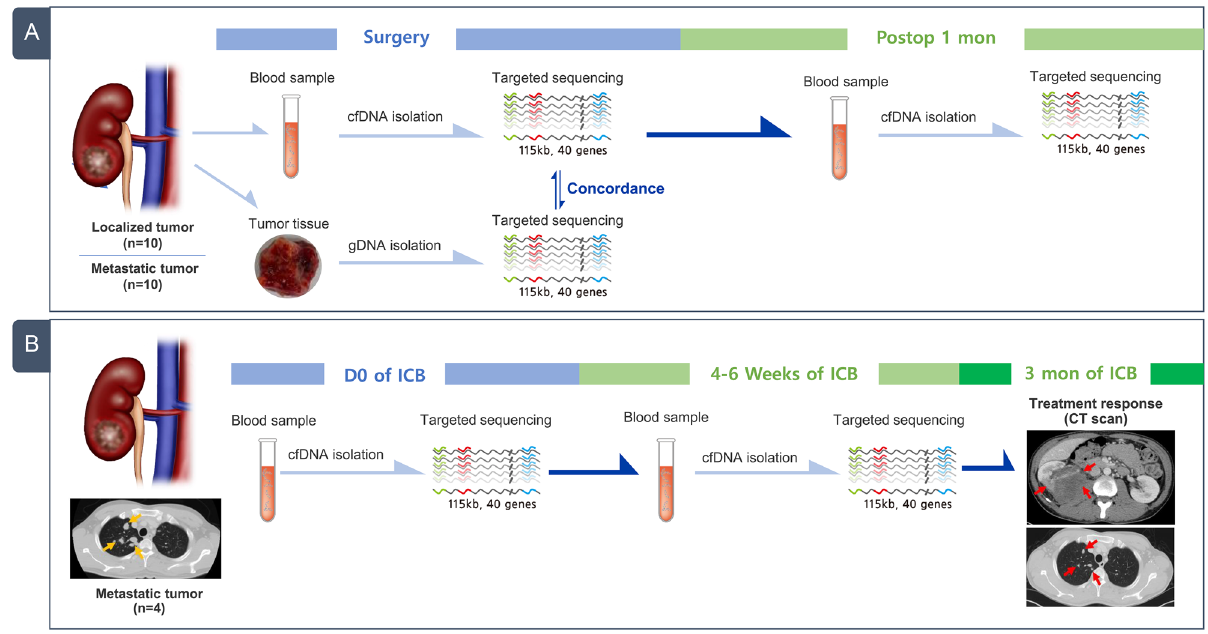
Figure 1. Schematic representation of the current study design. ( A ) Cohort of comparative tumor mutation profiles in tumor samples and circulating tumor DNA (ctDNA) from plasma samples collected from patients with renal cell carcinoma (RCC) who underwent radical nephrectomy (n = 20). ( B ) Cohort of ctDNA examined in patients with metastatic RCC who received first-line immune checkpoint blockade therapy (n =